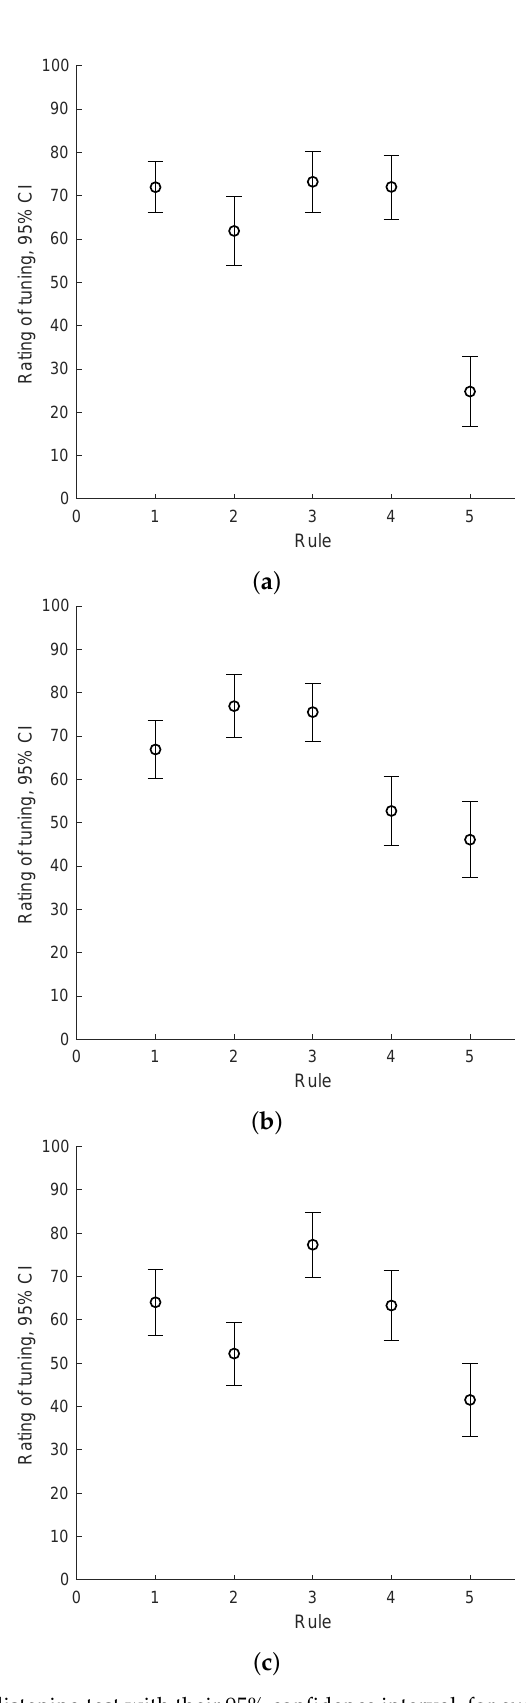
Figure 3. Results of the listening test with their 95% confidence interval, for example octaves ( a ) A5–A6, ( b ) D6–D7, and ( c ) Bb5–Bb6 (typical plot). The rules are explained in the caption of Figure